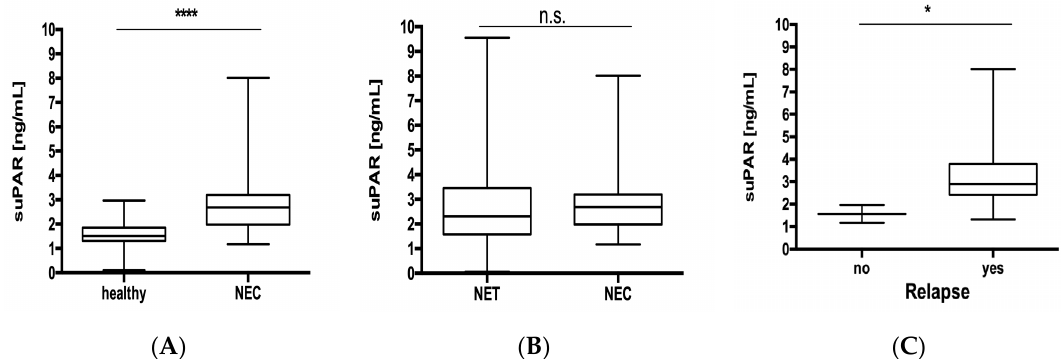
Figure 5. suPAR levels do not discriminate between neuroendocrine tumors and neuroendocrine carcinoma. ( A ) Serum concentrations of suPAR are significantly elevated in patients with NEC compared to healthy controls. ( B ) suPAR levels were similar in patients with NEC and NET. ( C ) NEC patients with disease relapse after surgery displayed elevated suPAR concentrations. Box plot are displayed, where the bold line indicates the median per group, the box represents 50% of the values. The horizontal lines show minimum and maximum values of calculated nonoutlier values (* p < 0.05, **** p < 0.0001). NEC, neuroendocrine carcinomas.